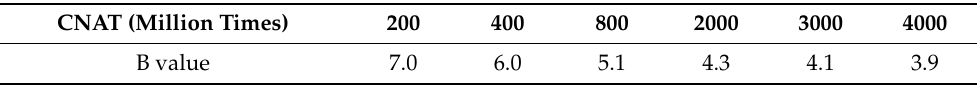
Table 13. Control standard of attenuation rate B